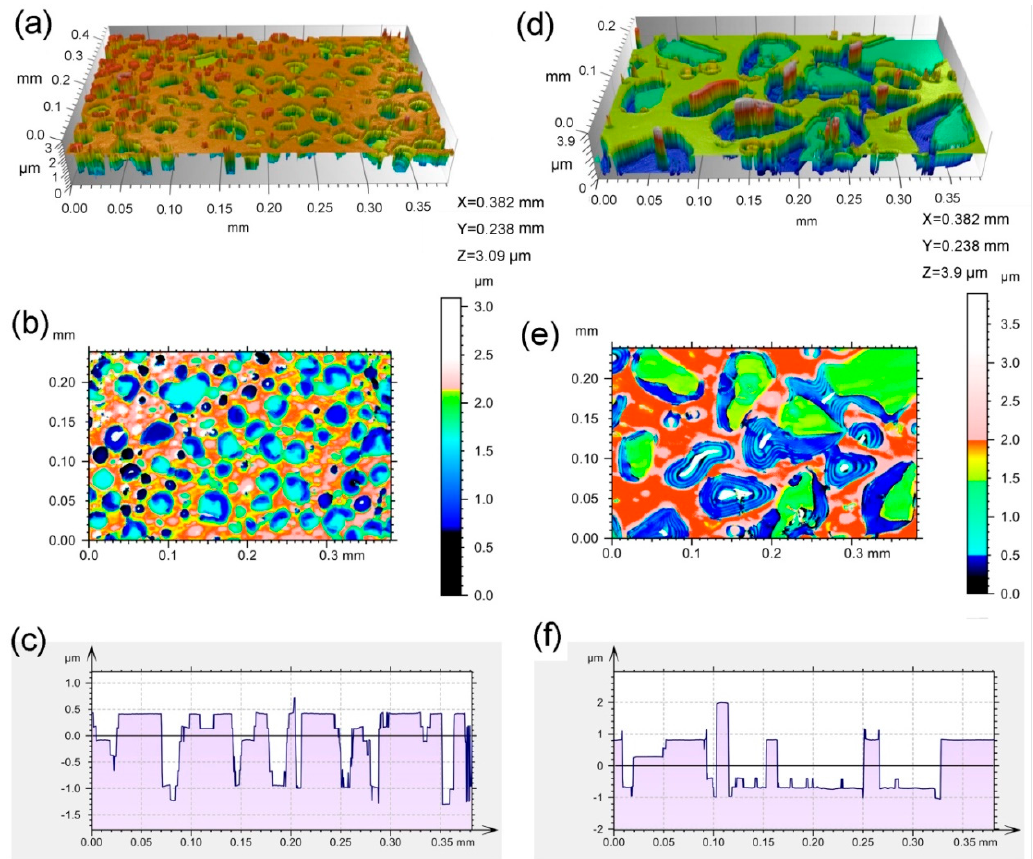
Figure 3. ( a , d ) show surface morphology observed in the three-dimensional profile, ( b , d ) show the height distribution in a two-dimensional profile, and ( c , f ) show the contour curve obtained